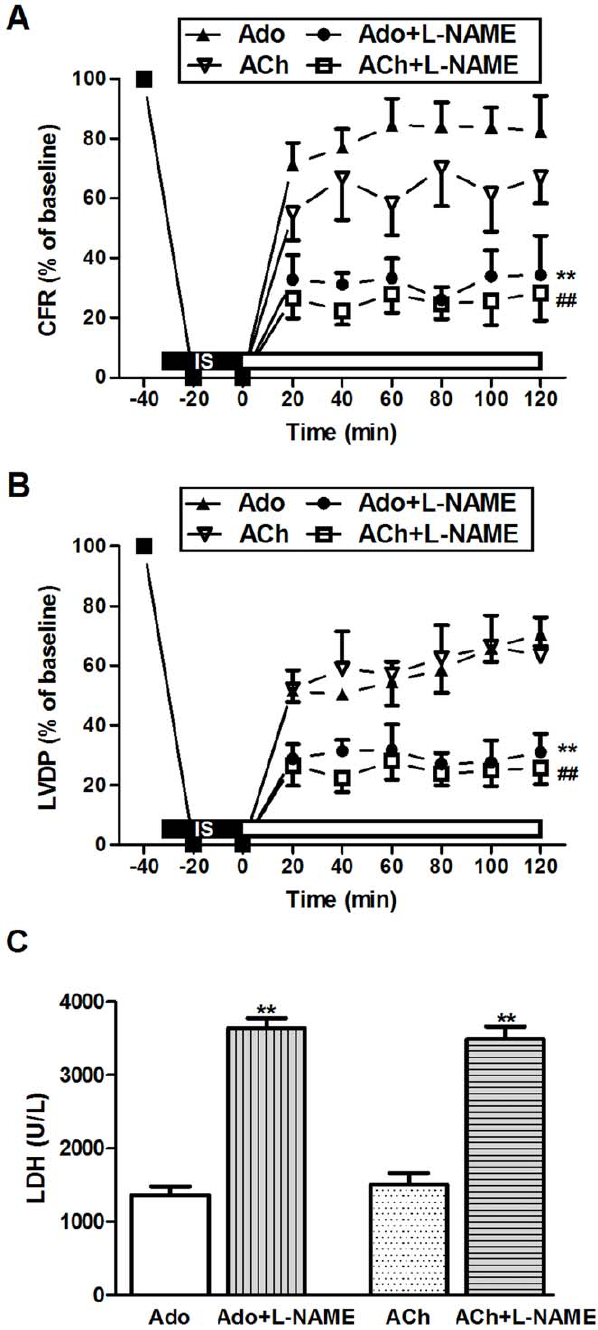
Figure 3. Effects of NOS Inhibitor on adenosine/acetylcholine- mediated cardioprotection. (A) NOS inhibitor L-NAME abolished the increase in coronary flow rate (CFR) mediated by adenosine/acetylcho- line; (B) NOS inhibitor L-NAME abolished the left-ventricular developed pressure (LVDP) improvement mediated by adenosine/acetylcholine; (C) NOS inhibitor L-NAME abolished the decrease in LDH release mediated by adenosine/acetylcholine in coronary effluent. Ado: adenosine; ACh: acetylcholine; IS: iscehmia. ** P , 0.01 vs. Ado; ## P , 0.01 vs. ACh (n=6 in each group).